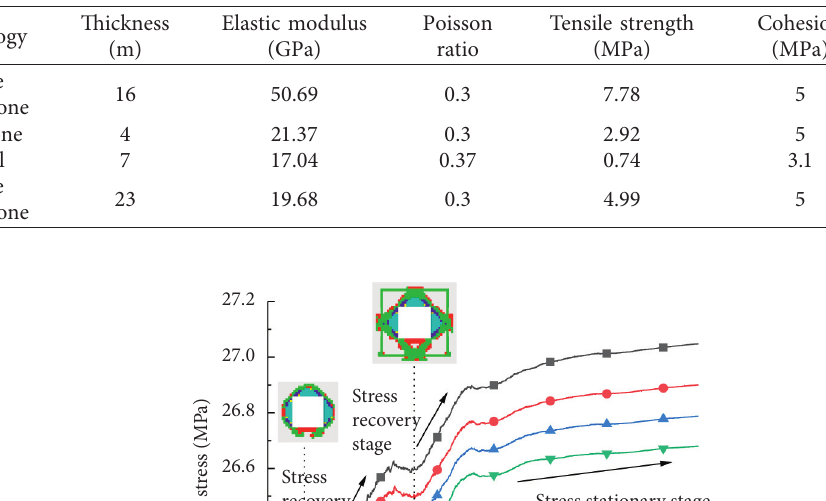
Table 1: Model parameters in the FLAC 3D model.